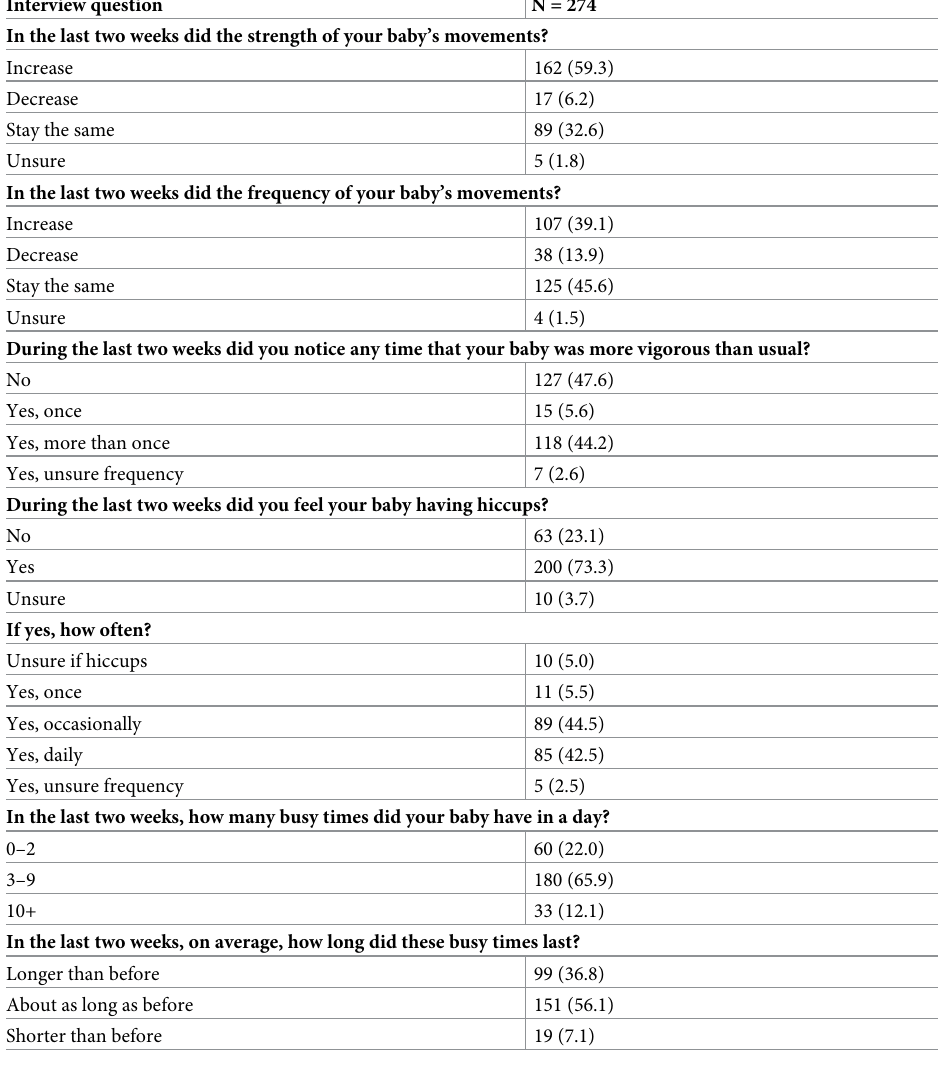
Table 2. Fetal movement strength, frequency, hiccups and ‘busy times’ (N = 274). Interview